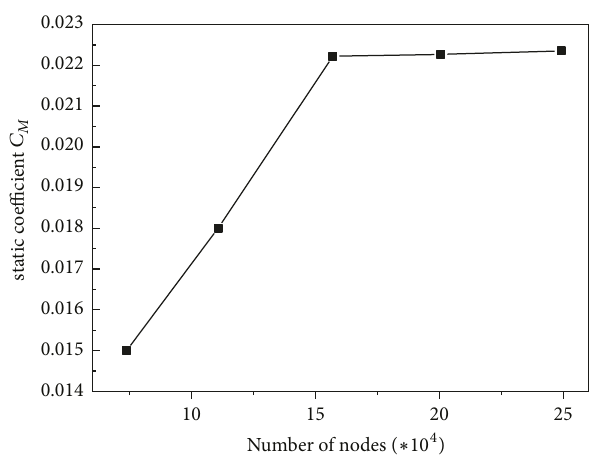
Figure 5: Grid independent verification.